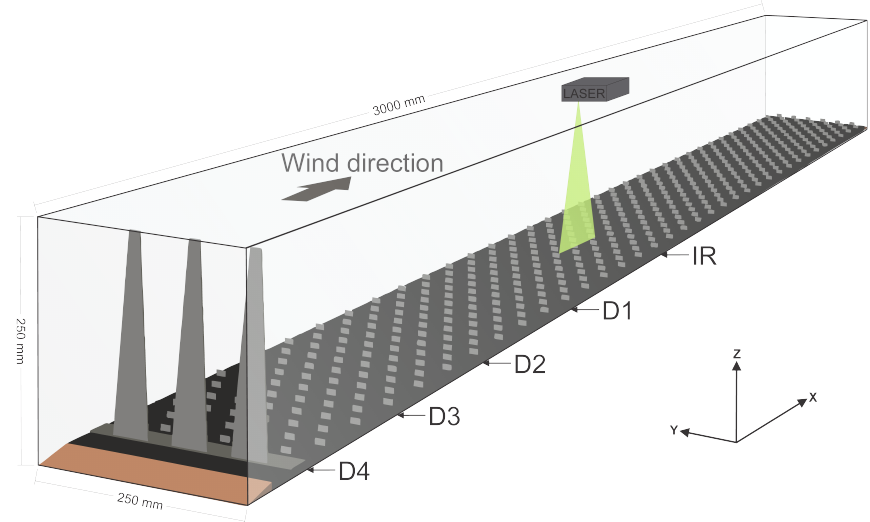
Fig. 1. Scheme of the wind tunnel test section with the spires installed at the beginning and with the surface covered by the roughness elements (ABLM4D4 case). The green triangle represents the laser sheet including the investigated region (IR). Labels D1-D4 denote the spires